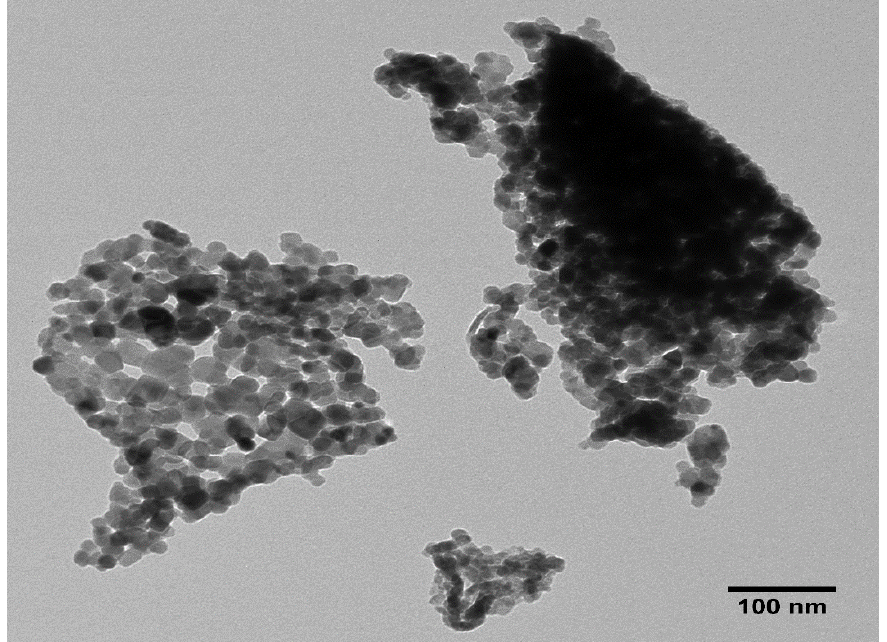
Figure 4. TEM micrograph of SnO 2 NPs.